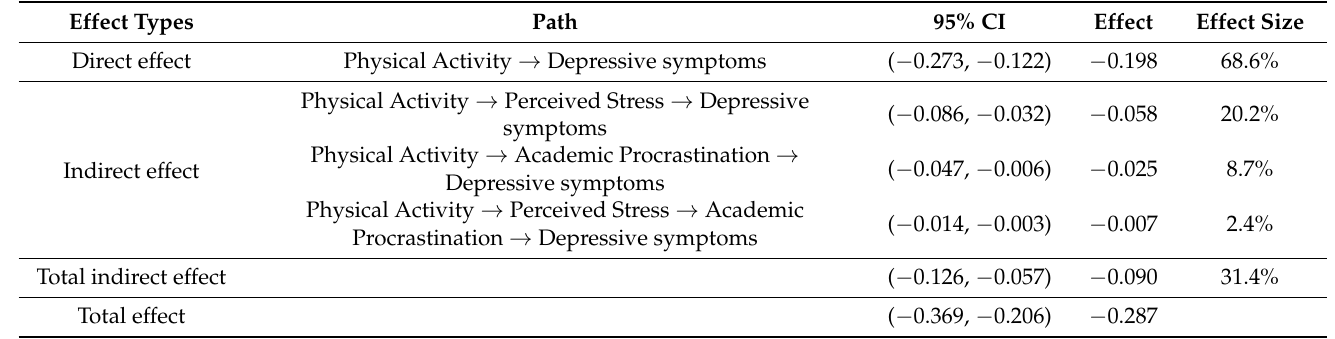
Table 4. Analysis of the mediating effect of perceived stress and academic procrastination on the relationship between physical activity and depressive symptoms and its effect size.